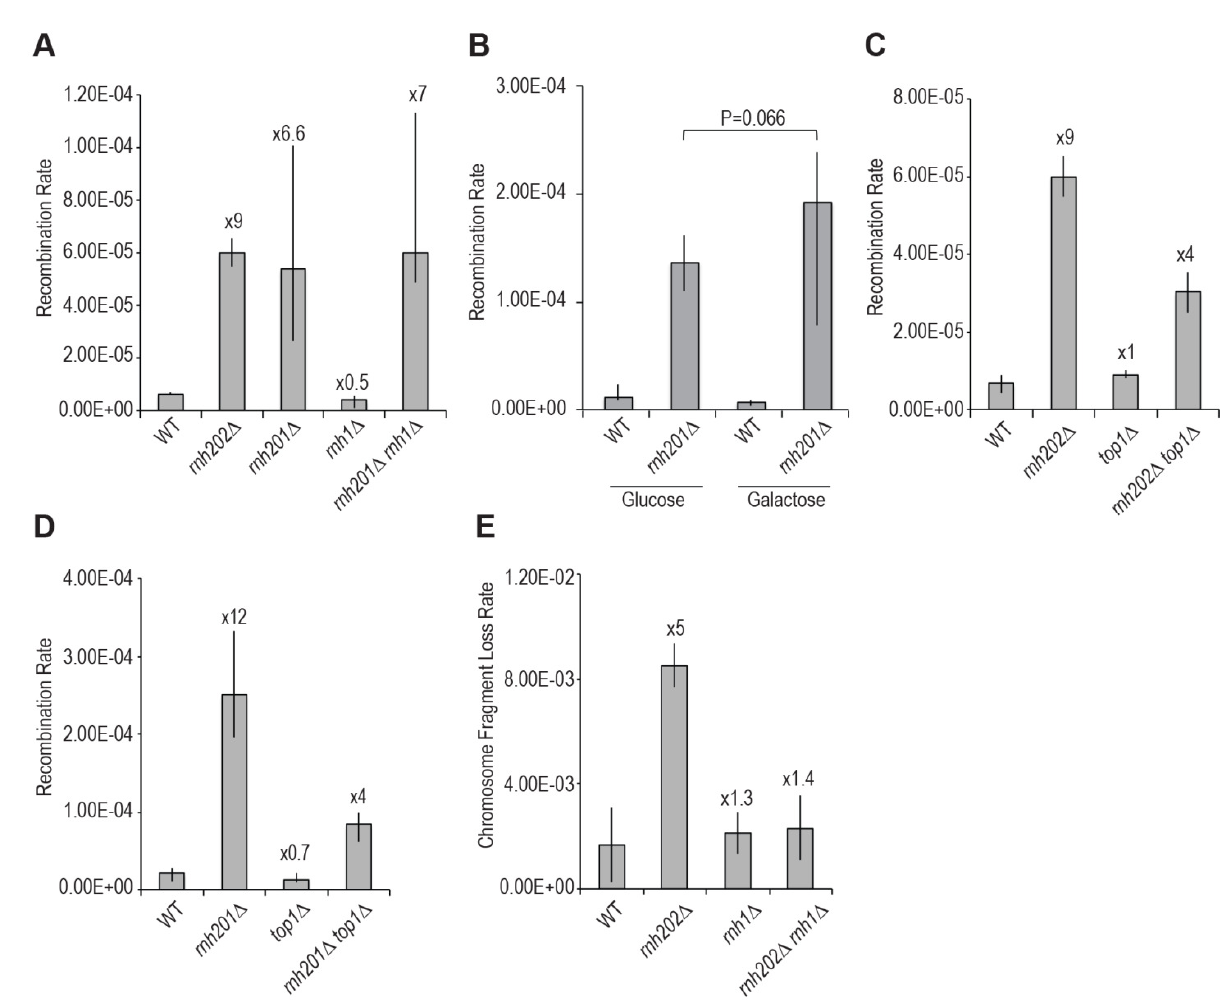
FIGURE 1: Intrachromosomal gene conversion is increased in RNase H2-defective cells. (A) Recombination rates of gene conversion are shown as median rates with 95% confidence limits ( n = 18) in RNase H1 and RNase H2 mutant strains. The reporter is a duplication of leu2 genes at the LEU2 locus. (B) Effect of RNase H1 over-expression in intrachoromosomal gene conversion rates. Recombination rates of the ade2 duplication reporter with a Gal-Rnh1 plasmid are shown with 95% confidence limits ( n = 12). (C) Effect of TOP1 deletion on the gene conversion recombination rate using the leu2 duplication reporter. The wild type (WT) and rnh202 ∆ rates are taken from panel A. (D) Re- combination rates of gene conversion are shown as median rates with 95% confidence limits ( n = 18) in RNase H2 mutant strains using a different recombination reporter consisting of a duplication of ade2 genes at the ADE2 locus. The effect of TOP1 deletion on this reporter is also shown. (E) Chromosome fragment loss in a haploid strain is shown. Median rates with standard deviations are